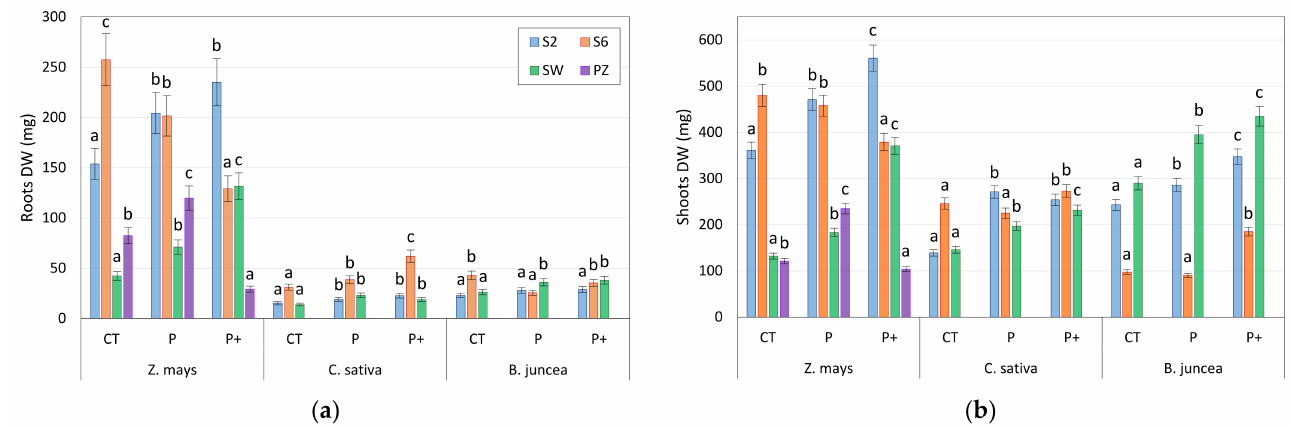
Figure 4. Dry weights (mg pot − 1 ) of ( a ) roots and ( b ) shoots of Z. mays , C. sativa, and B. juncea grown on soil control (CT) and As-contaminated soil treated with phosphate (P). The addition of PGPR bacteria (first set of isolates) is indicated with a “+” sign. Values are the mean of three replicates, and the error bars show the standard deviation. Values with different letters are significantly different at the 5% probability level (Tukey’s